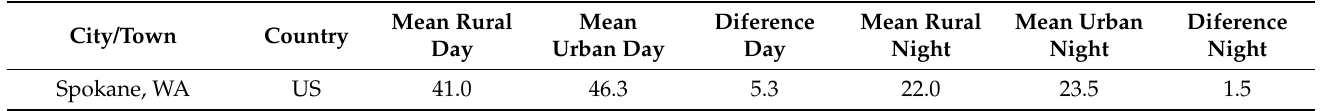
Table 3. Values of SUHI (difference between rural and urban LSTs) over selected cities for 26 June 2021. Mean LST values over rural and urban areas both for day and night conditions are also included. Values are given in ◦